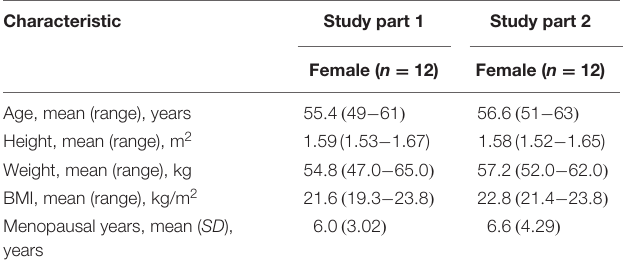
TABLE 1 | Baseline characteristics of the randomized study population ( n =